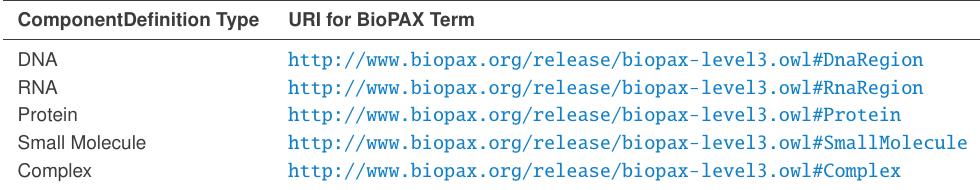
Table 2: BioPAX terms to specify the molecule type using the types property of a ComponentDefinition .